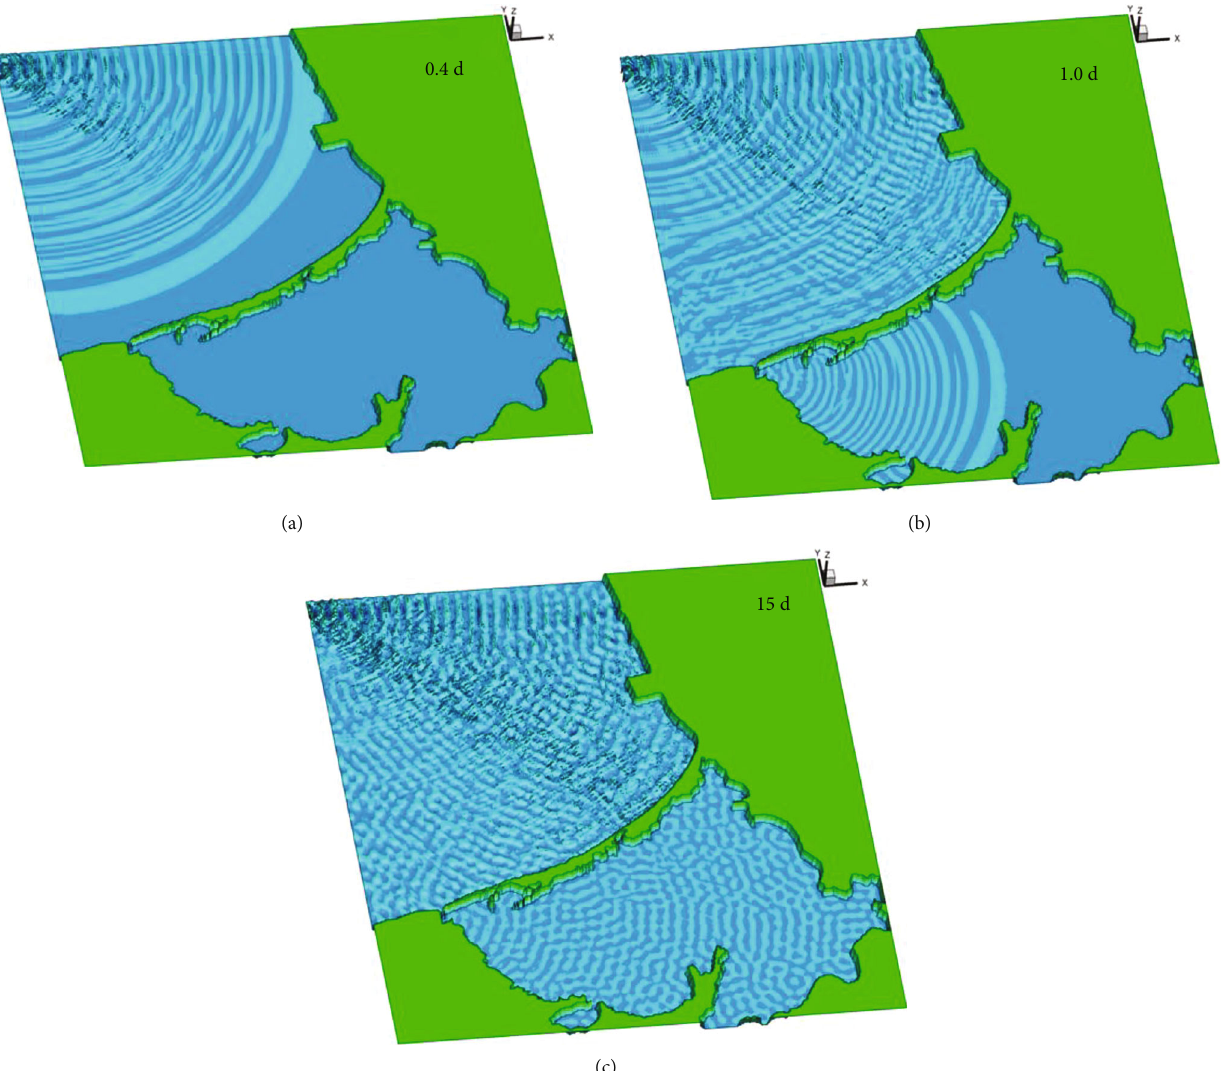
Figure 9: Development of wave propagation in the studied domain in extraordinary conditions: (a) 0.4 day (9.6 hour) simulation. (b) One day simulation. (c) Fifteen days